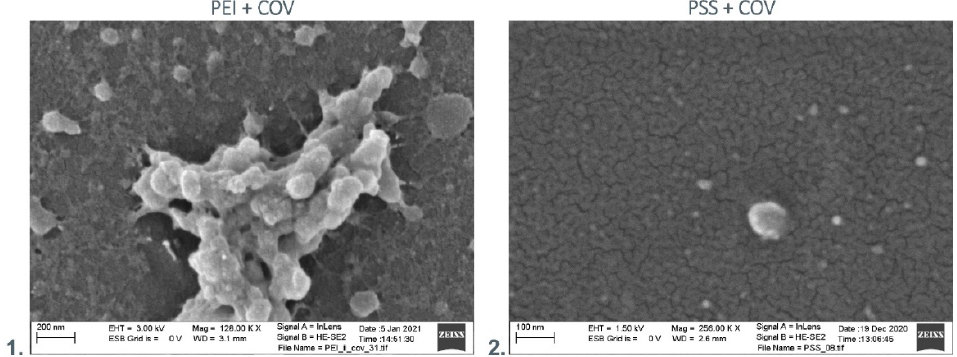
Figure 1. SEM image of COV deposited on the surface of the 1. PEI membrane, 2. PSS